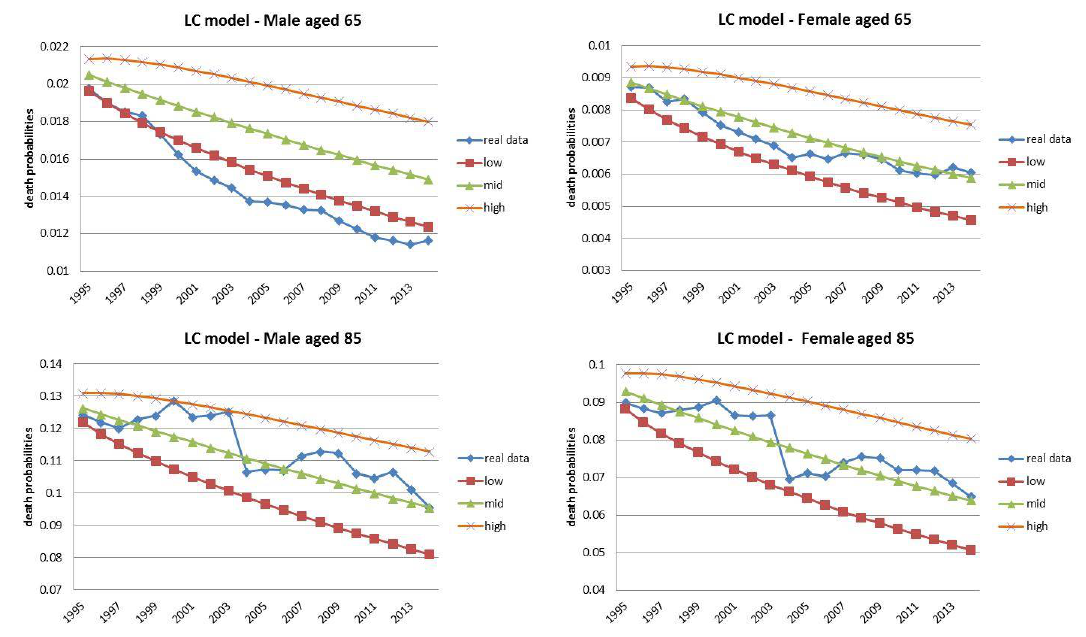
Figure 7. LC Fixed Horizon Backtest forecast: comparison between observed death rates and the corresponding 95% confidence interval of the forecast based on the time series 1975–1994.